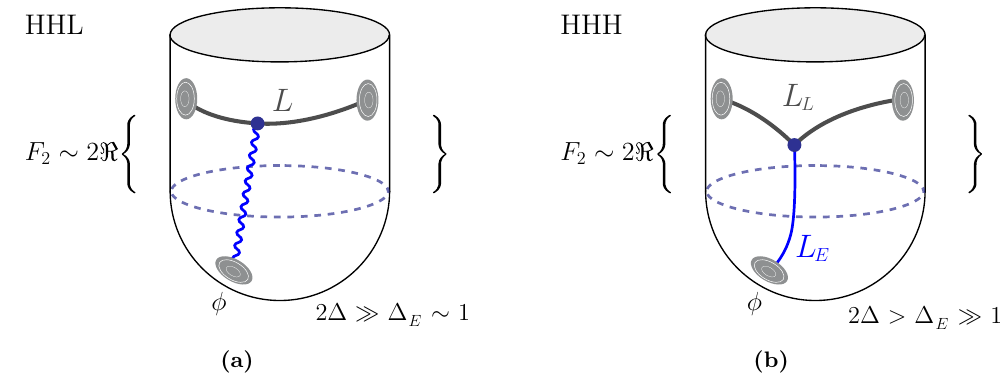
1 one can also E (cid:29)